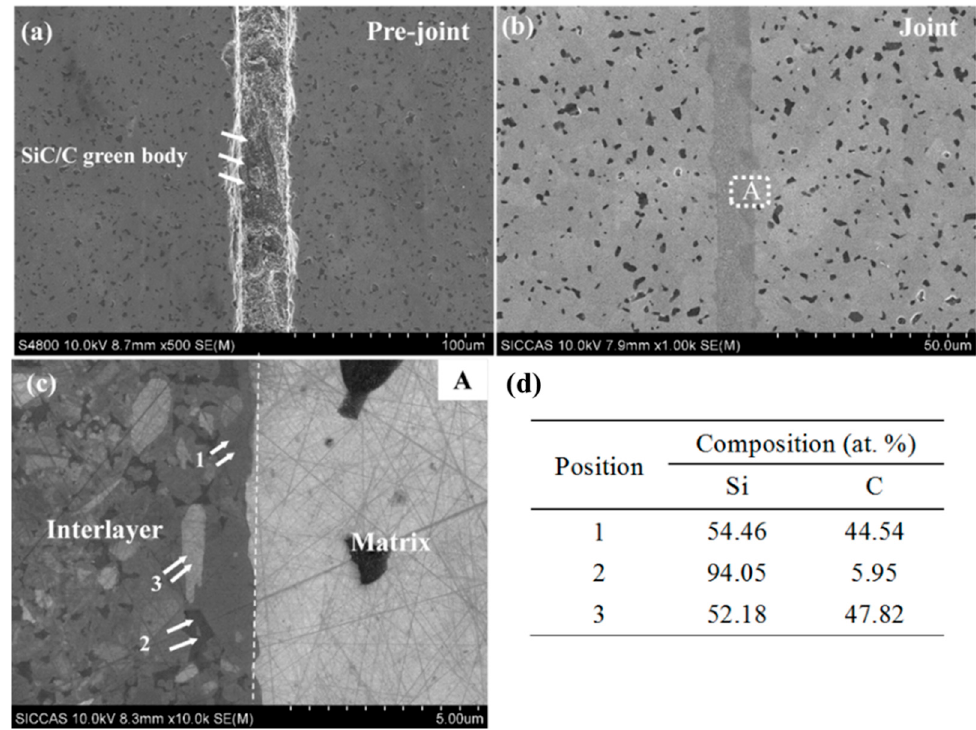
Figure 6. Microstructure of the joint of W-4: ( a ) Pre-joint; ( b ) joint; ( c ) region A in ( b ); ( d ) the element compositions of the regions marked in ( c ).